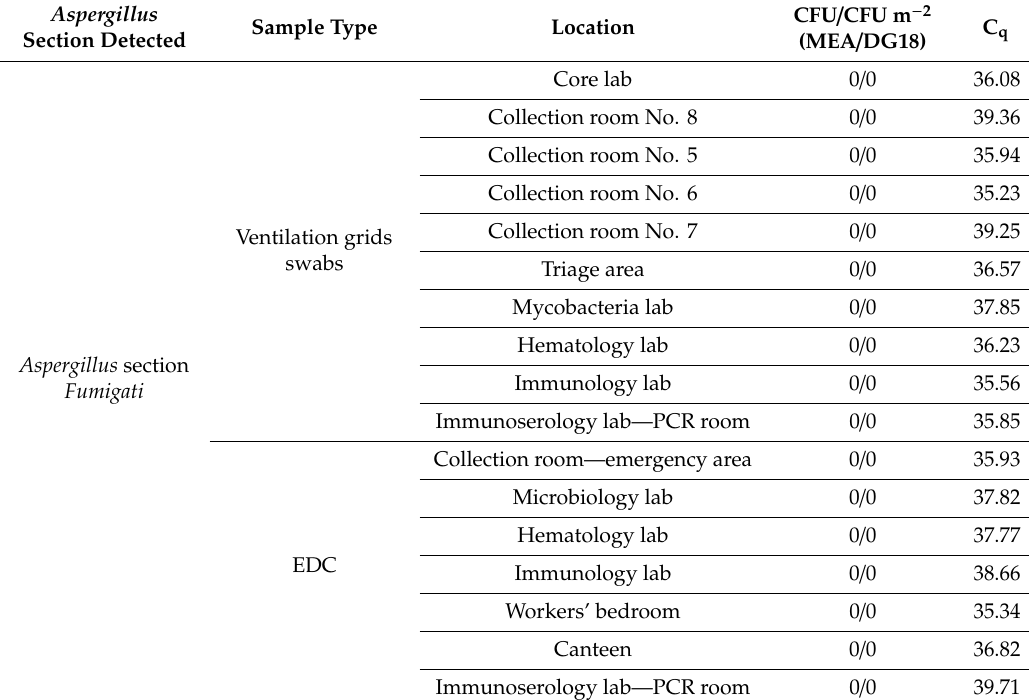
Table 7. Molecular detection results from the EDC and ventilation grids swab